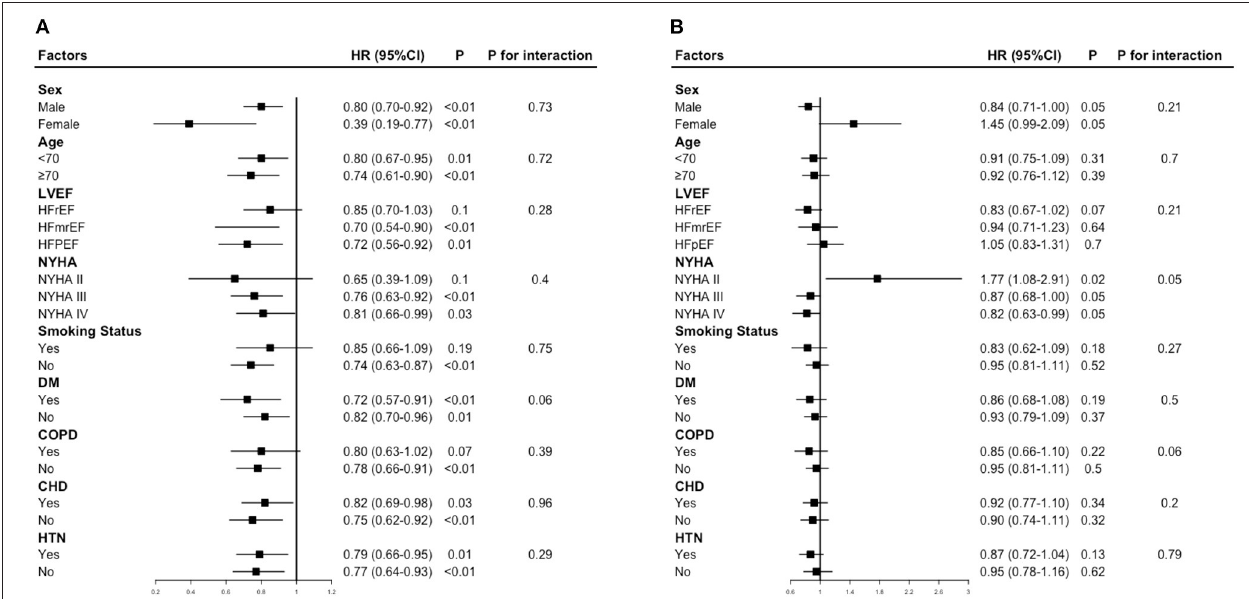
FIGURE 3 | Hazard ratios for mortality according to a 1 -SD increase in LBM index or FM index. (A) Hazard ratios per 1 standard deviation–increase in LBM index for mortality. (B) Hazard ratios per 1 standard deviation–increase in FM index for mortality. Each stratification was adjusted for all factors in model 3, except for the stratification factor